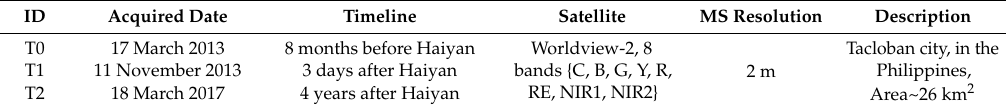
Figure 1. The red line shows the track of Typhoon Haiyan (map on the left ), overview of Tacloban city; blue objects show the distribution of land use samples (training and validation) for the event time (map on the right) . Table 1. Description of data used.